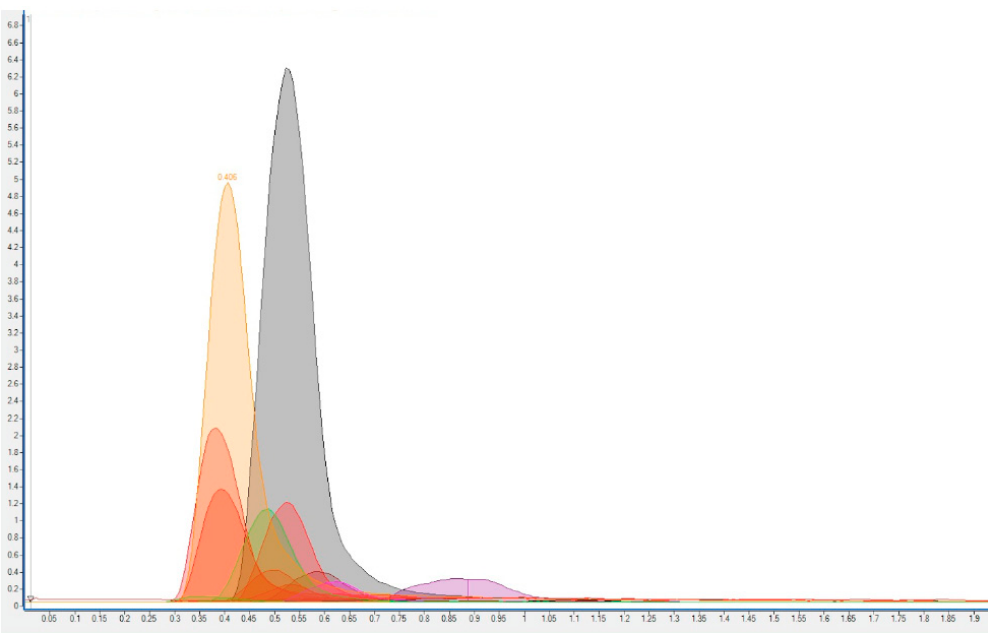
Figure 1. Shows a chromatogram of a urine sample.